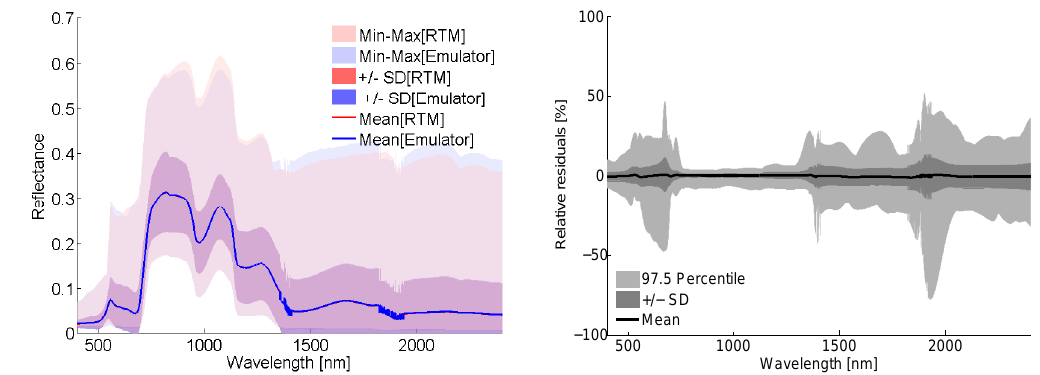
Figure 4. Left : General statistics (mean, standard deviation (SD), min-max) for SCOPE validation and corresponding emulated spectra using the SCOPE1000-NN-40PCA emulator. The SD and min-max boundaries areas are presented as semi transparent so that their shapes for both datasets can be distinguished (red: RTM, blue: emulator). Consequently, the blended purple (SD) and pink (min-max) colors indicate the degree of RTM vs. emulated data overlapping. Right : Relative residuals between SCOPE and emulated refelectance spectra. The areas represent the maximal spectral difference (light gray) and 1 SD (dark gray) for the 97.5 percentile. The black line represents the mean spectral residual.